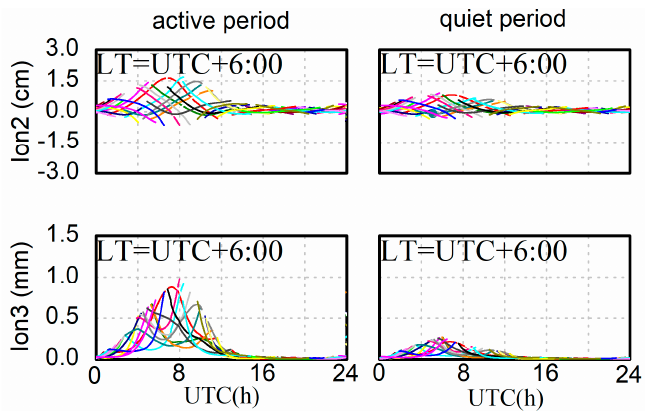
Figure 6. Time series of Ion2 terms ( top ) and Ion3 terms ( bottom ) of GPS L1 for station COCO on DOY 238 (quiet period, right) and 249 (active period, left) in 2017.